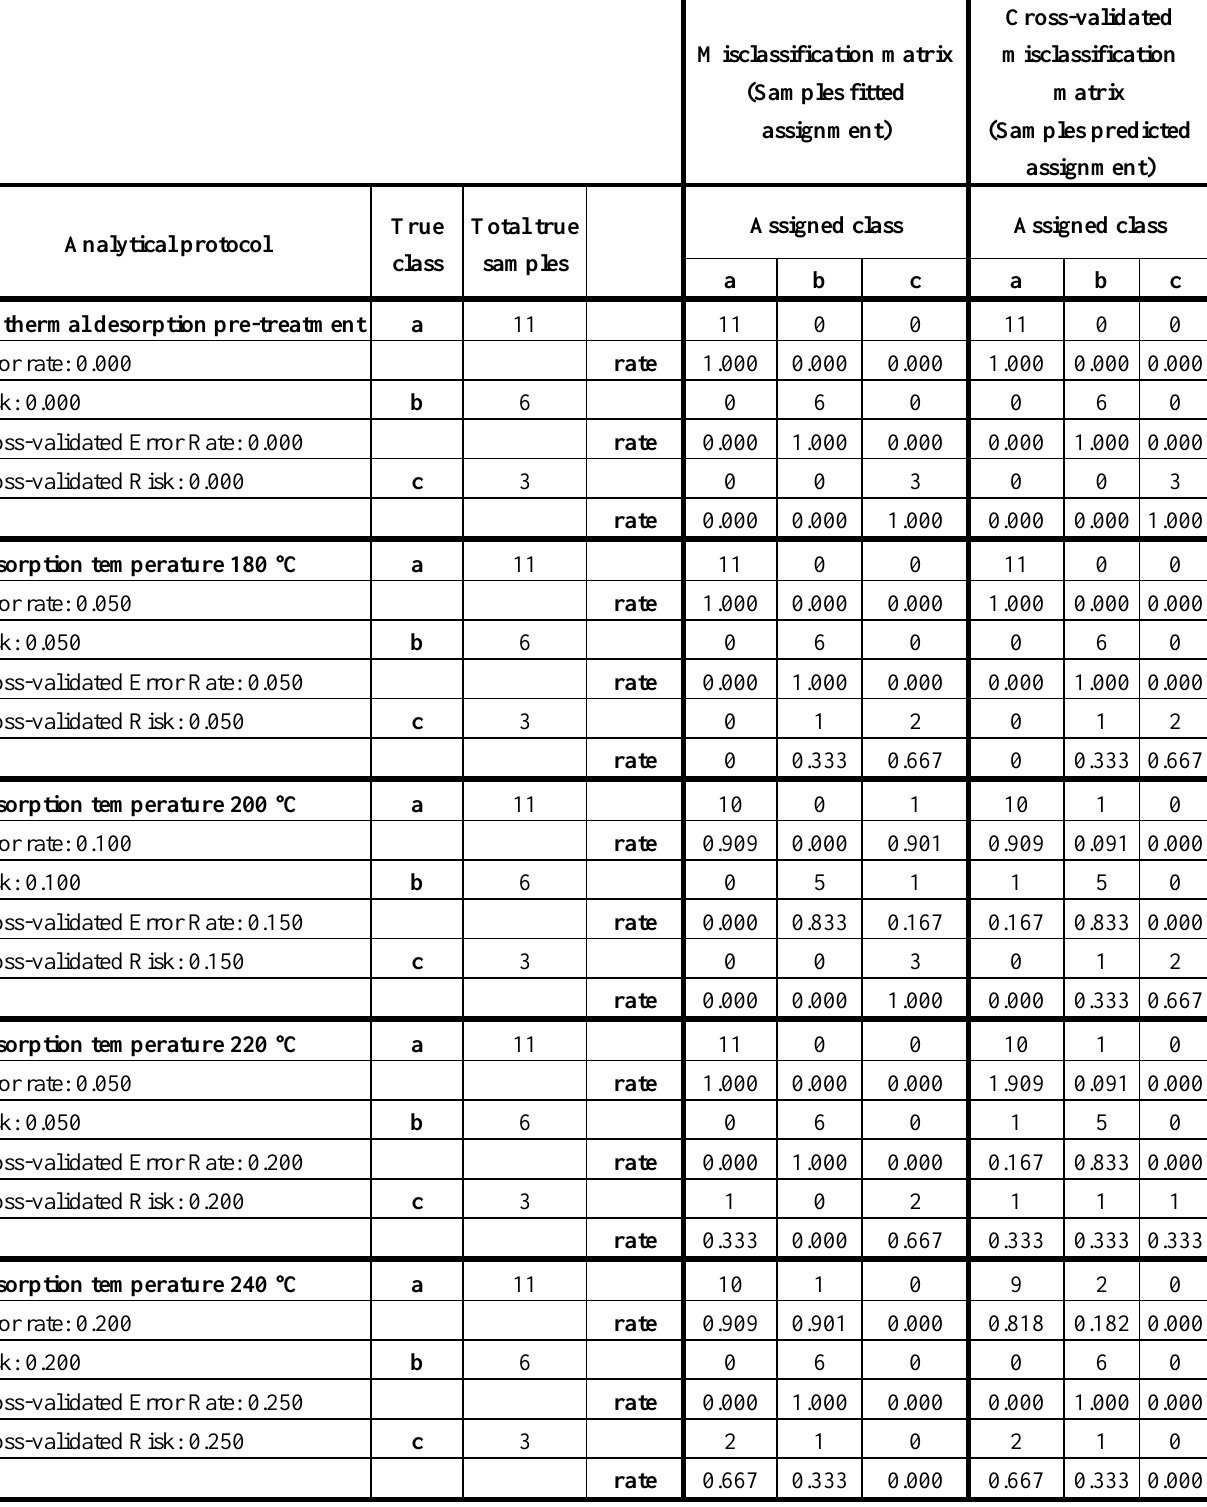
Table 4. CART classification performances. Class a) , non-contaminated samples; Class b) , samples contaminated below the legal limit; Class c) , samples contaminated above the legal